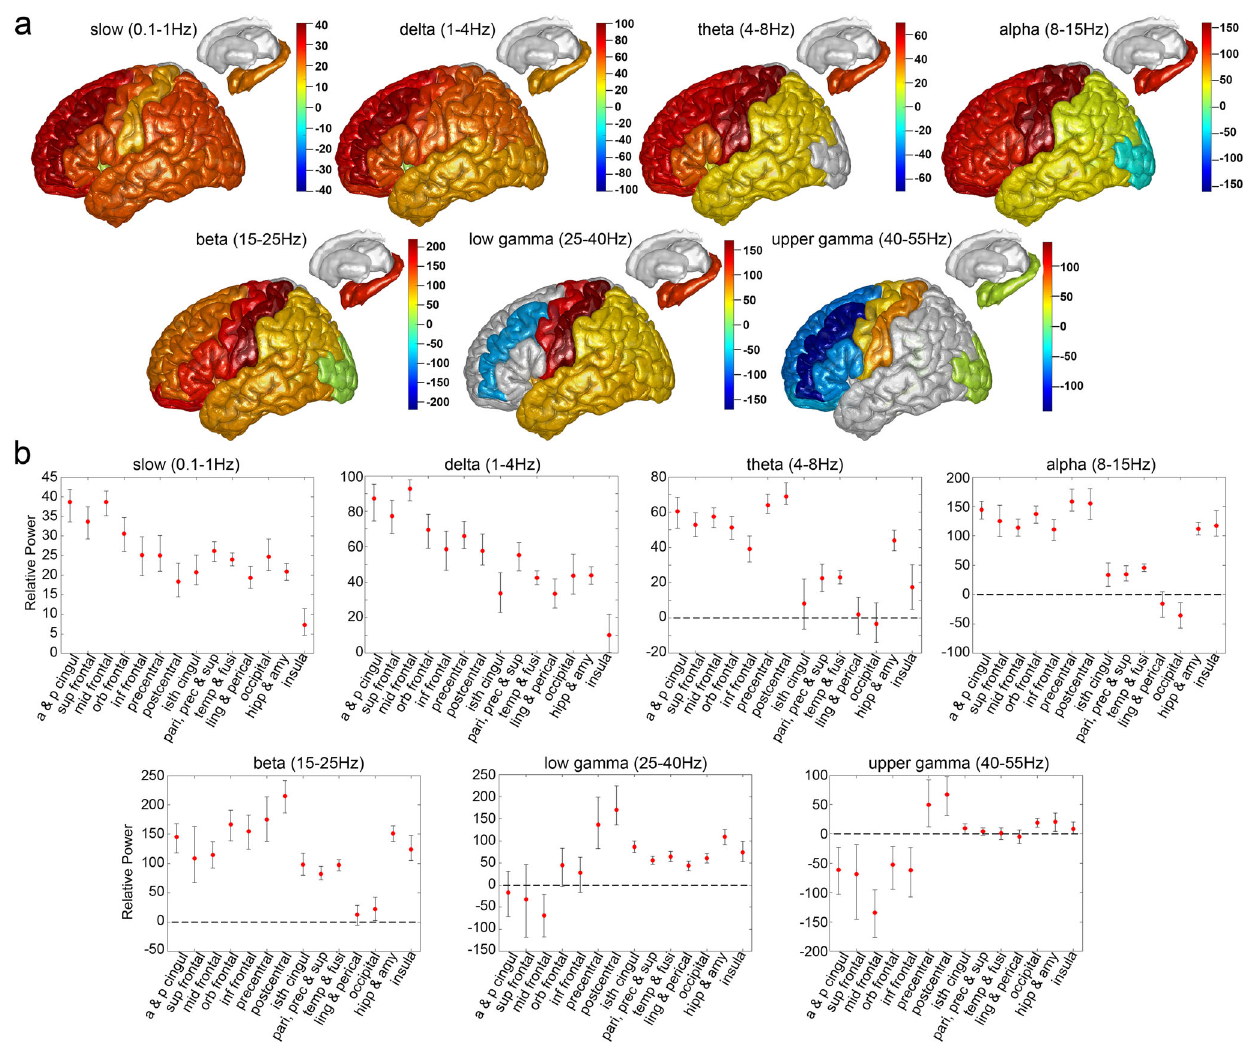
Fig. 3 | Structural mapping for intracranial EEG power changes after propofol bolus relative to ketamine period at 7 frequencies. a , The mean differences in power(dB)afterpropofolbolusrelativetoketamineperiodwerecalculatedfor606 channels across 7 subjects and plotted on Colin27 brain template. Warmer colors indicateanincreaseinpower,coolercolorsindicateadecreaseinpower,andagrey colorindicatesnochangeinpower(con fi denceintervaloverlapszero). b ,Meanand bootstrap 95% con fi dence interval for intracranial EEG power changes after pro- pofolbolusrelative toketamine periodat 7 frequenciesfor